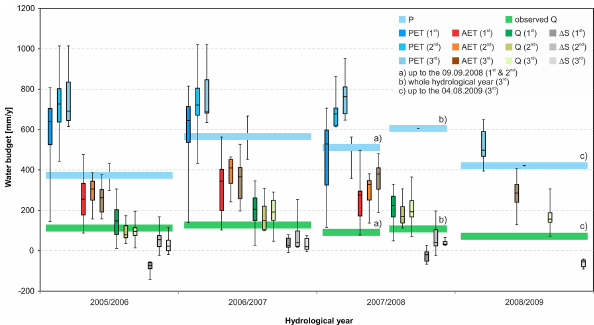
Figure 2. Mean and standard deviation of the water budget compo- nents simulated in the first, second and third